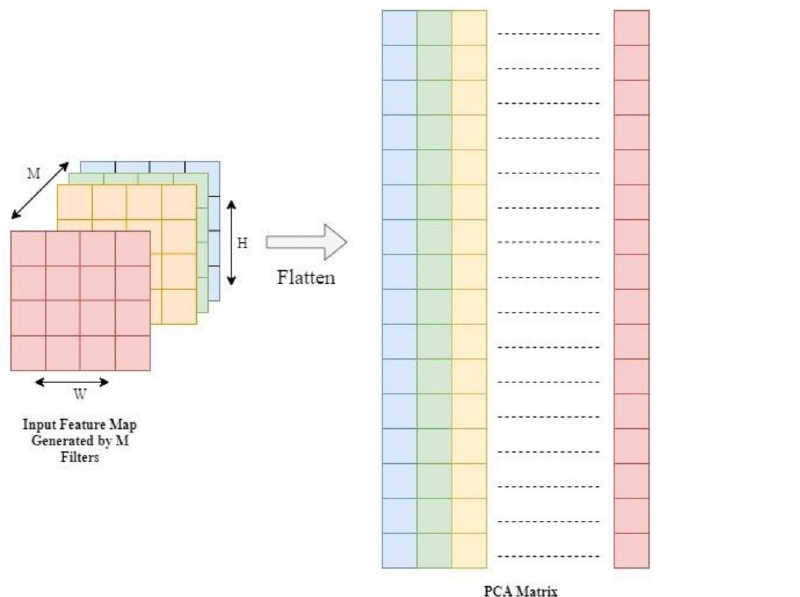
Fig 3. Flattened activation matrix as input to